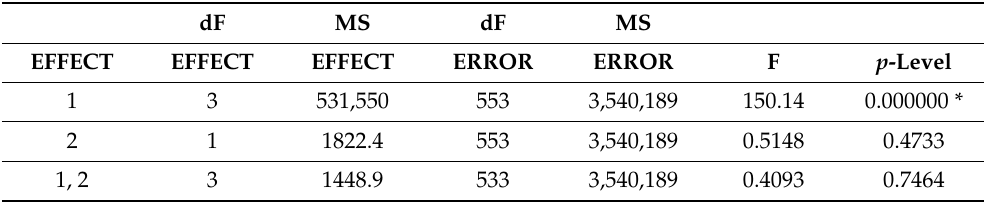
Table 5. Copying speed (BHK speed): General MANOVA.